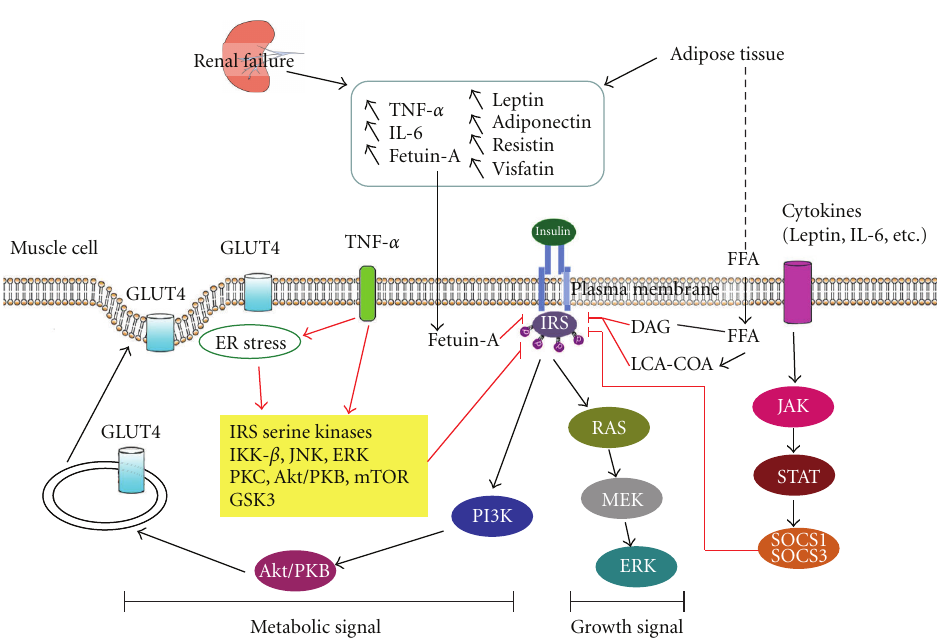
Figure 1: Insulin resistance in chronic kidney disease. Renal failure and adipose tissue lead to systemic inflammation and increased plasma levels of adipokines. TNF- α activates adipose tissue lipolysis, which generates free-fatty acids (FFAs). On muscle cells, FFAs activate transcription factors, such as peroxisome proliferator-activated receptor (PPAR), and generate messengers including diacylglycerol (DAG) and long-chain acyl-CoA (LCA-CoA), which will lead to protein kinase C (PKC) activation and dephosphorylation of insulin receptor substrate (IRS)-1/2. On muscle cells, TNF- α activates a series of kinases including IKK- β , c-Jun NH2-terminal kinase (JNK), extracellular signal-regulated kinase (ERK), protein kinase C (PKC), Akt (PKB), mammalian target of rapamycin (mTOR), and glycogen synthase kinase 3 (GSK3) responsible for phosphorylation of insulin receptor (InsR) and IRS-1 on serine/threonine residues. Inhibition of IRS- 1 function will block Akt leading to cytosol glucose transporter 4 (GLUT4) sequestration. Fetuin-A could also inhibit IRS and induce low-grade inflammation. IL-6 is responsible for the induction of di ff erent suppressors of cytokine signaling (SOCS) proteins through the Janus kinase/signal transducer and activator of transcription (Jak/STAT)-signaling pathway. SOCS will inhibit IRS-1/2 and protein kinase A. Endoplasmic reticulum stress seems to be another factor linking inflammation and insulin resistance at the molecular level. Red line illustrates the mechanism of CKD-related factors in